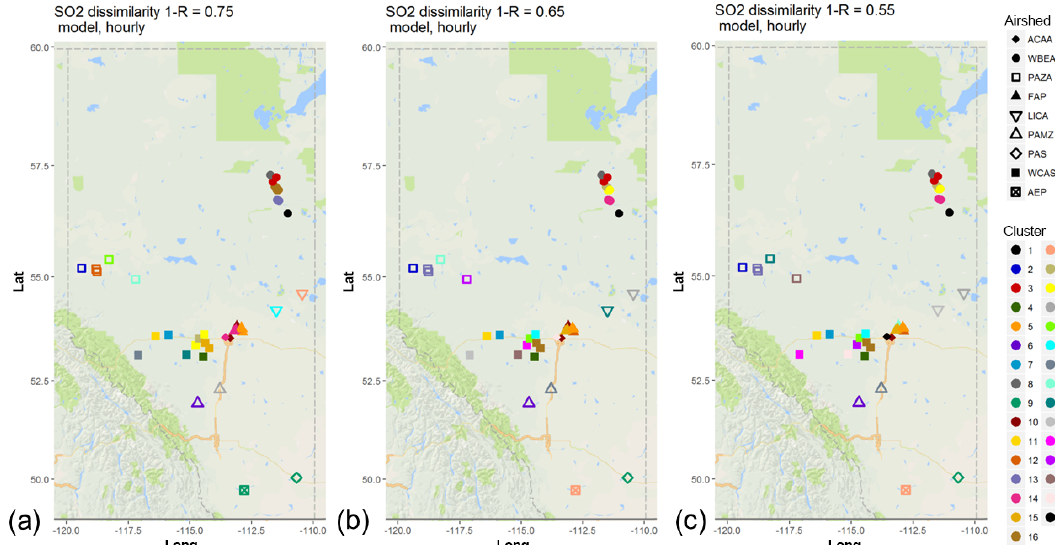
Figure 8. Associativity analysis for modelled SO 2 hourly time series using 1 − R as the metric to compute the dissimilarity matrix, assuming a dissimilarity level of (a) 0.75, (b) 0.65, and (c) 0.55. Stations are colour-coded according to cluster formation, and airsheds are plotted with different polygons. The acronyms for the airsheds are as in Fig.